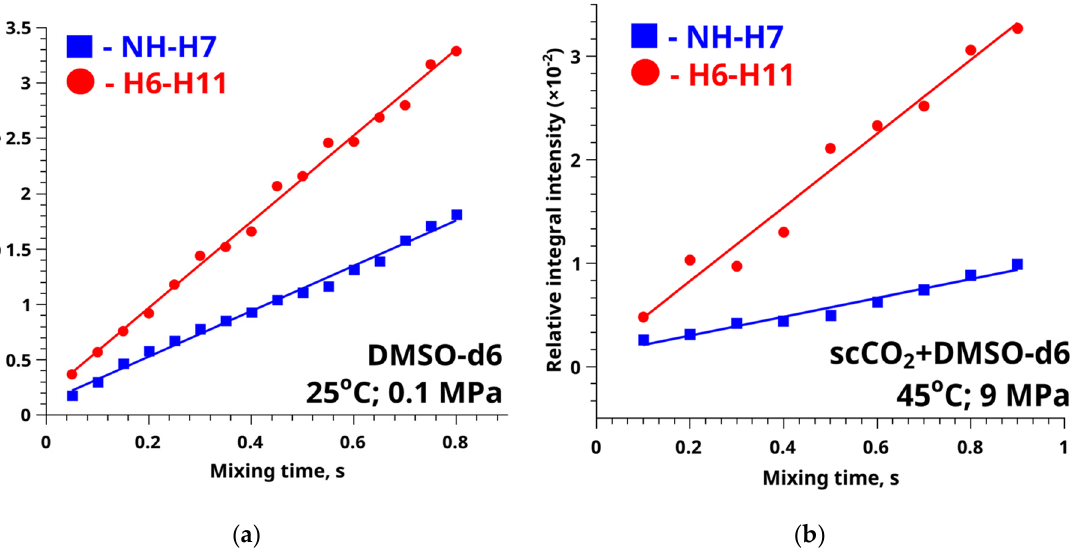
Figure 6. Graphs of averaged integral intensity vs. mixing time for the conformational (the red line) and reference (the blue line) distances obtained by analyzing the NOESY spectra of FFA-DMSO-d 6 ( a ) and FFA-SC-CO 2 +DMSO-d 6 at 45 ° С and 9 MPa ( b ).